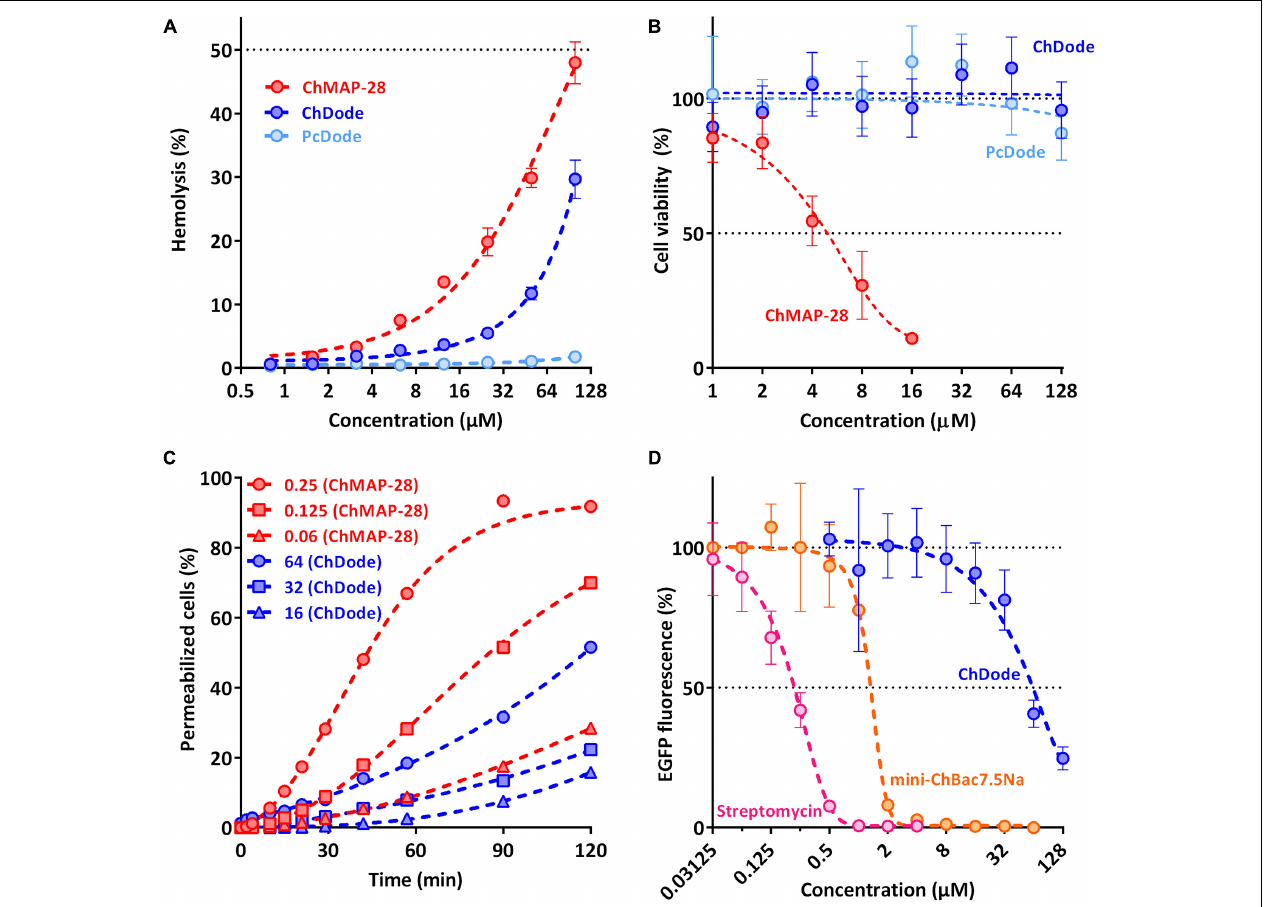
FIGURE 8 | Biological activity of cathelicidins. (A) Hemolytic activity of the peptides after 1.5 h incubation (hemoglobin release assay). (B) Cytotoxicity of the peptides toward human keratinocytes (HaCaT) cells after 24 h incubation (MTT-assay). (C) Kinetics of changes in E. coli ML-35p cytoplasmic membrane permeability (ONPG assay). (D) Effects of goat cathelicidins and streptomycin at different concentrations on the fluorescence resulting from in vitro translation of EGFP with the use of E. coli BL21 (DE3) Star cell extract. Data are the mean ± SD of at least three independent experiments performed in